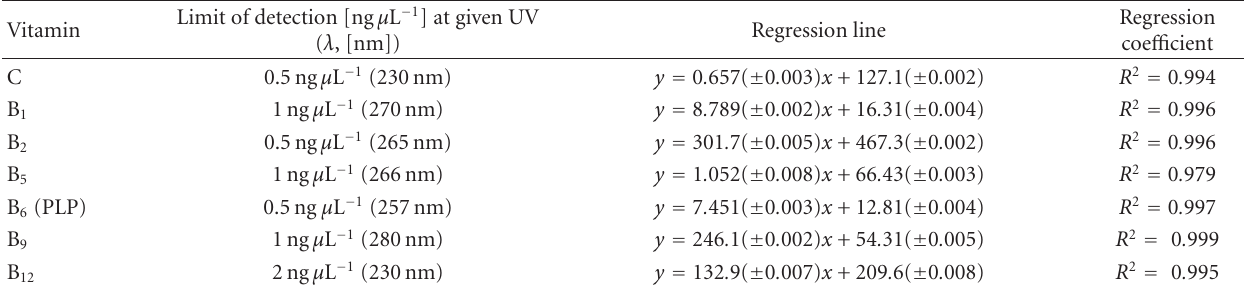
Table 4: Regression parameters of analysed vitamins. Regression parameters (regression equation [ ± SD of slope and intercept] and regression coe ffi cient) and detection limits (signal-to-noise ratio = 5 and injection volume = 3 μ L). Limit of detection [ng μ L − 1 ] at given UV Vitamin